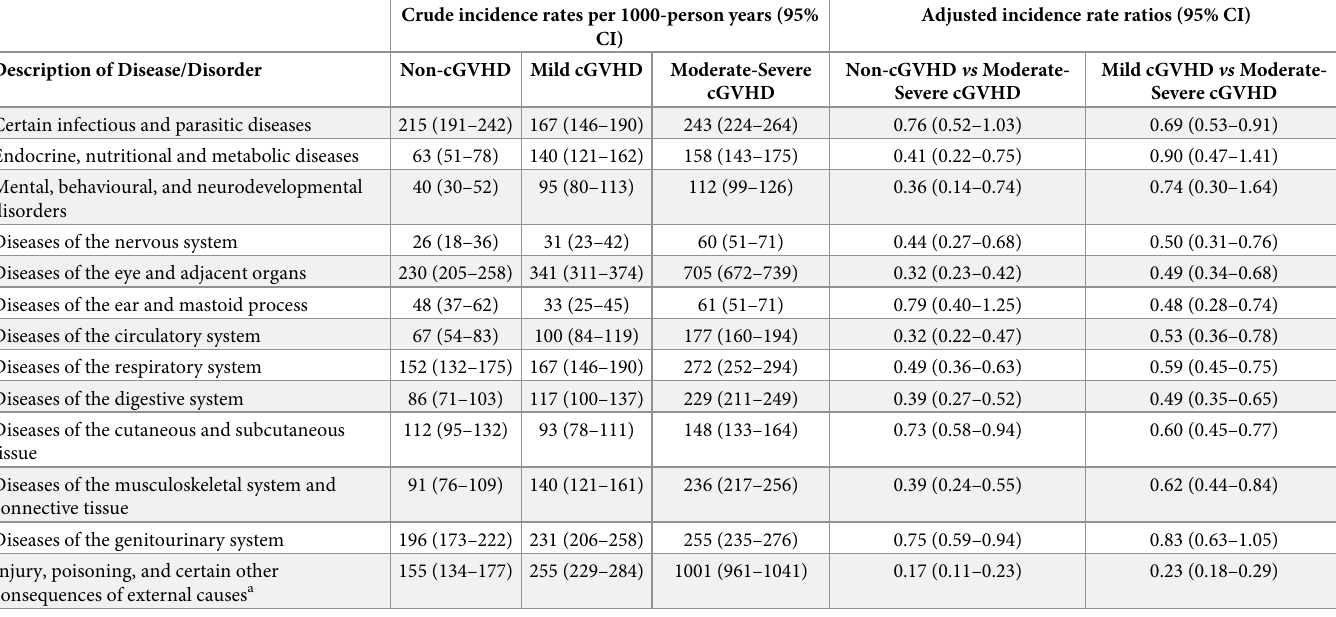
Table 4. Incidence of morbidities by cGVHD status among patients who survived � 6 months